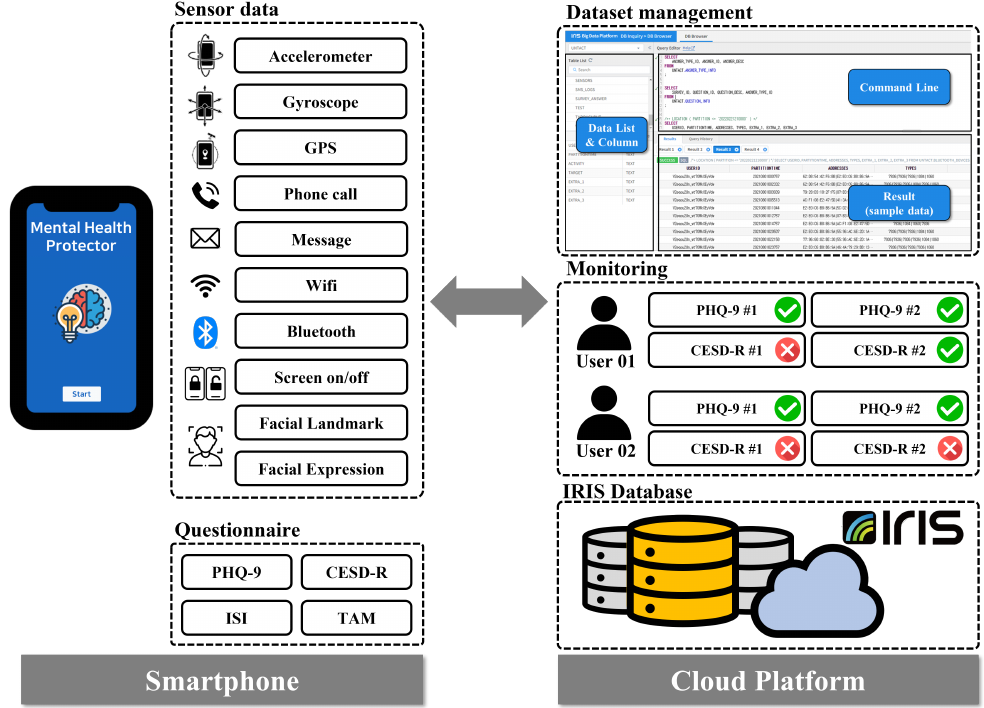
Figure 1. Proposed Architecture. This illustrates the architecture of the proposed depression predic- tion system. The “Mental Health Protector” application installed on the participant’s smartphone collects multimodal-based passive sensor data and active data, consisting of survey results. The collected data are transmitted to a cloud-based platform for data processing and storage. The partici- pant’s depression is predicted and monitored using the data transmitted to